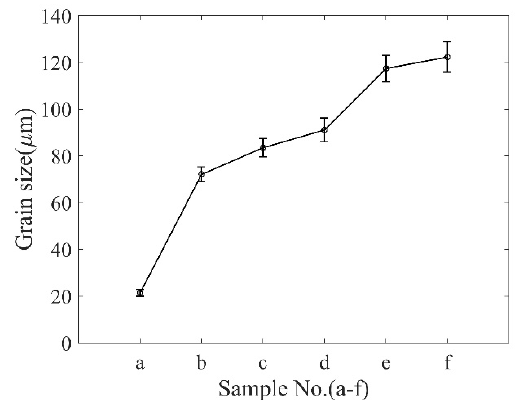
Figure 4. Variations in grain sizes for different specimens.